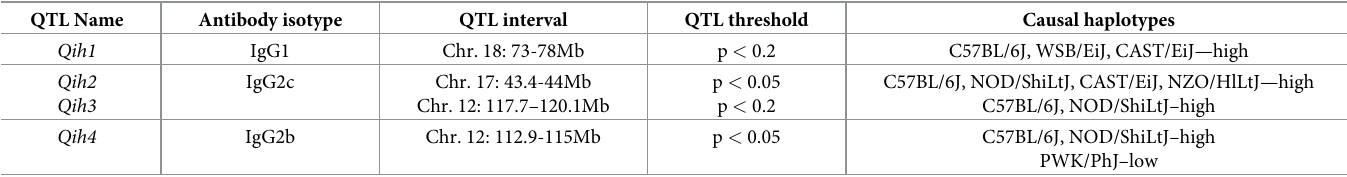
Table 2. QTL identified in homeostatic antibody screen and causal haplotypes driving each QTL.